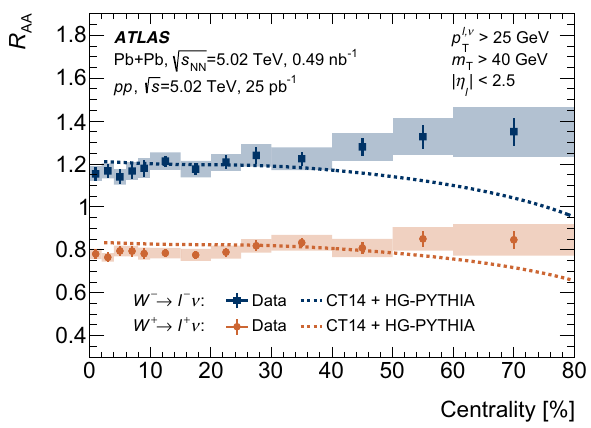
Fig. 15 Nuclear modification factor R AA obtained from the fiducial W + and W − boson production yields as a function of centrality per- centile. Error bars show statistical uncertainties, whereas systematic uncertainties are shown as the boxes around the data points. The sys- tematic uncertainties due to (cid:4) T AA (cid:5) and luminosity of the pp dataset are included in those boxes. The dashed lines show predictions which incorporate the centrality bias calculated using HG-PYTHIA for the ALICE charged-hadron production measurement [77]. These predic- tions are corrected for the isospin effect evaluated using MCFM with the CT14 NLO PDF